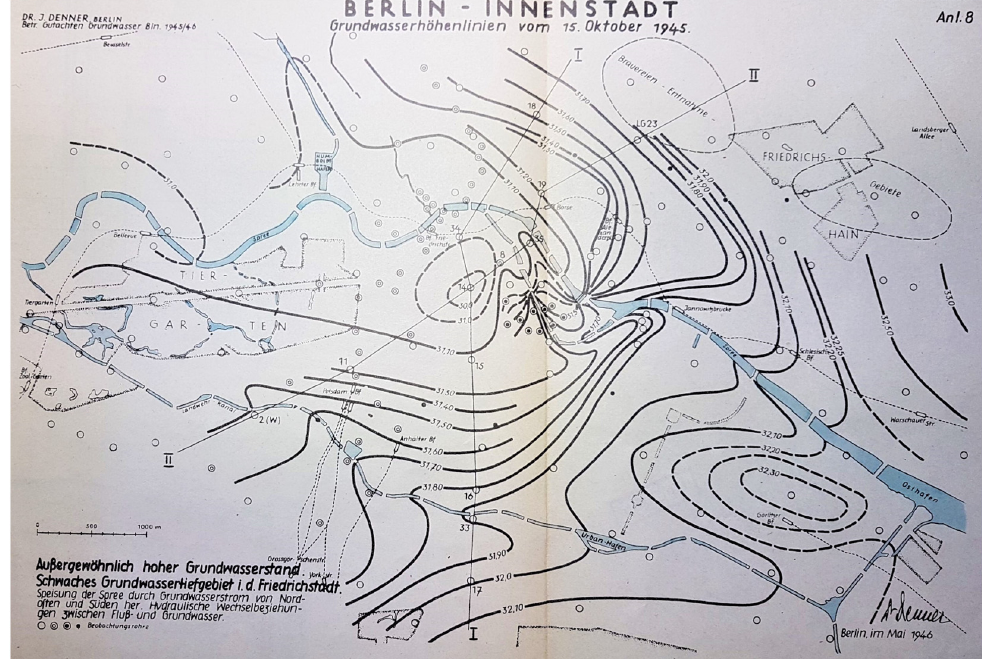
Figure 4. Map of groundwater levels in the centre of Berlin, 1945 (adapted from Ref. [75]) (annex 8).